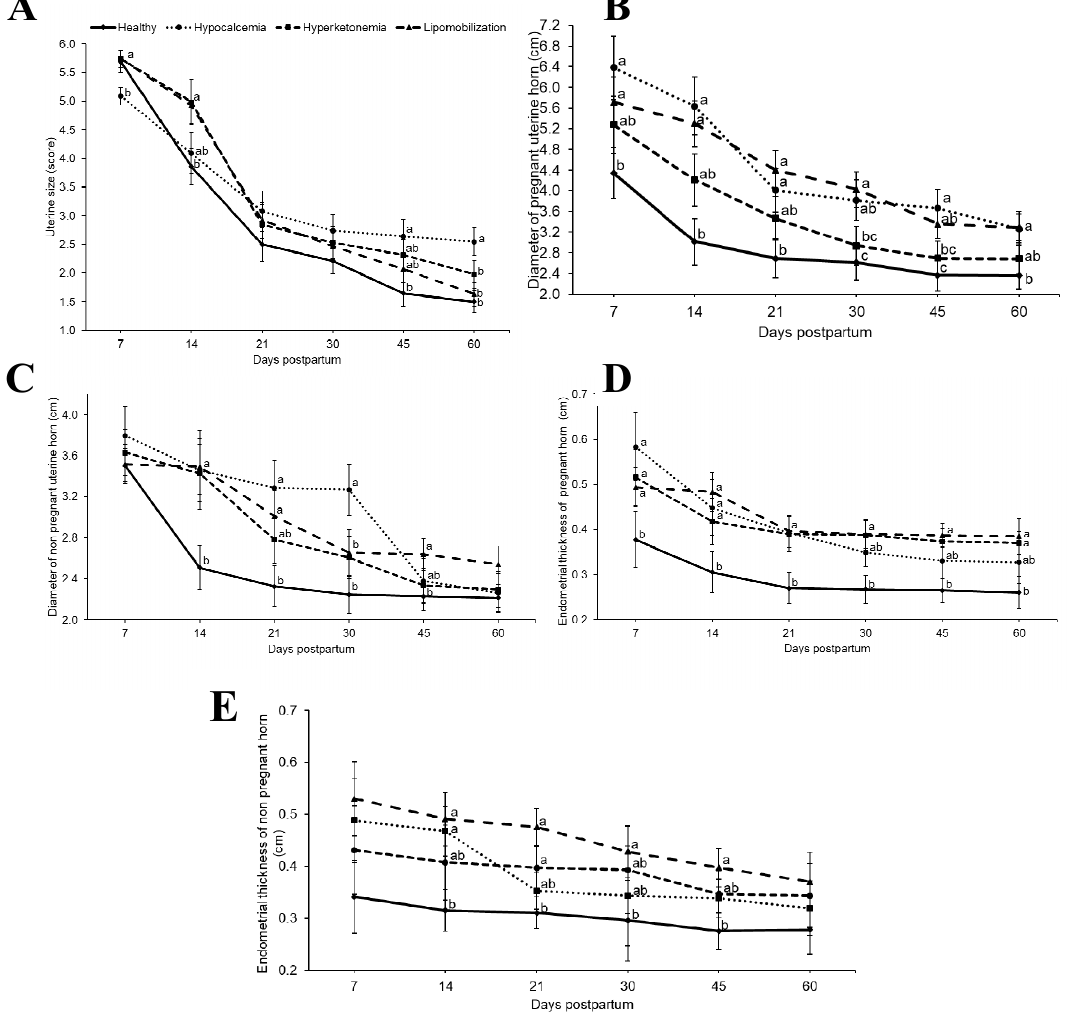
Figure 2. ( a ) Uterine size; ( b ) diameter of pregnant uterine horn; ( c ) diameter of non-pregnant horn; ( d ) endometrial thickness of pregnant horn; ( e ) endometrial thickness of non-pregnant horn (least squares means ± SEM) in relation to days postpartum. a,b,c Different superscript letters differ at p < 0.05.